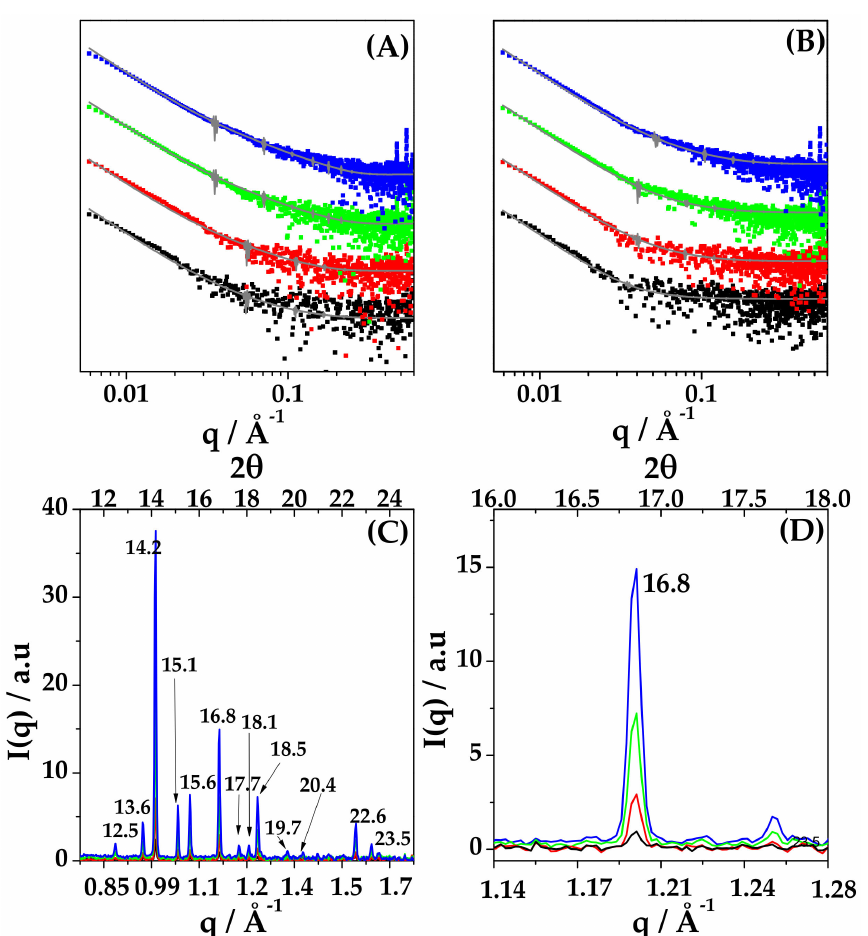
Figure 9. ( A , B ). SAXS intensity profiles of the HYA–DEX nanoparticles after subtraction of the intensity contribution of unbound HYA in water ( A ) and in PB ( B ). Lines are the fit with a core-shell polydisperse spherical model. Note: the intensity profiles were re-scaled for a better visualization. ( C , D ) WAXS spectra of HYA–DEX nanoparticles in water in the full q range ( C ) and in the region of one diffraction peak ( D ) to better visualize the increase of the intensity with concentration. Labels report the position of peaks expressed in 2 θ . HYA–DEX concentration: 1.4 mg/mL (black), 2.8 mg/mL (red), 5.6 mg/mL (green) and 11.2 mg/mL